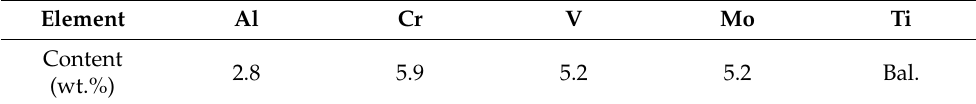
Table 1. Chemical